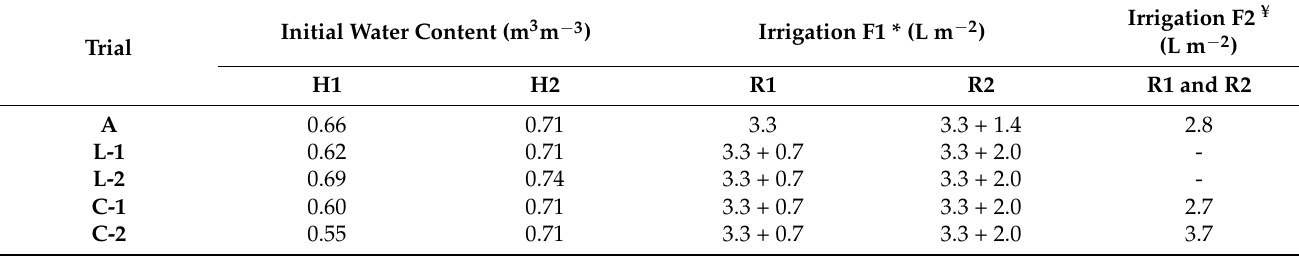
Table 1. Initial water content (m 3 m − 3 ) of the casing layer and irrigation program applied (L m − 2 ) in the trials.